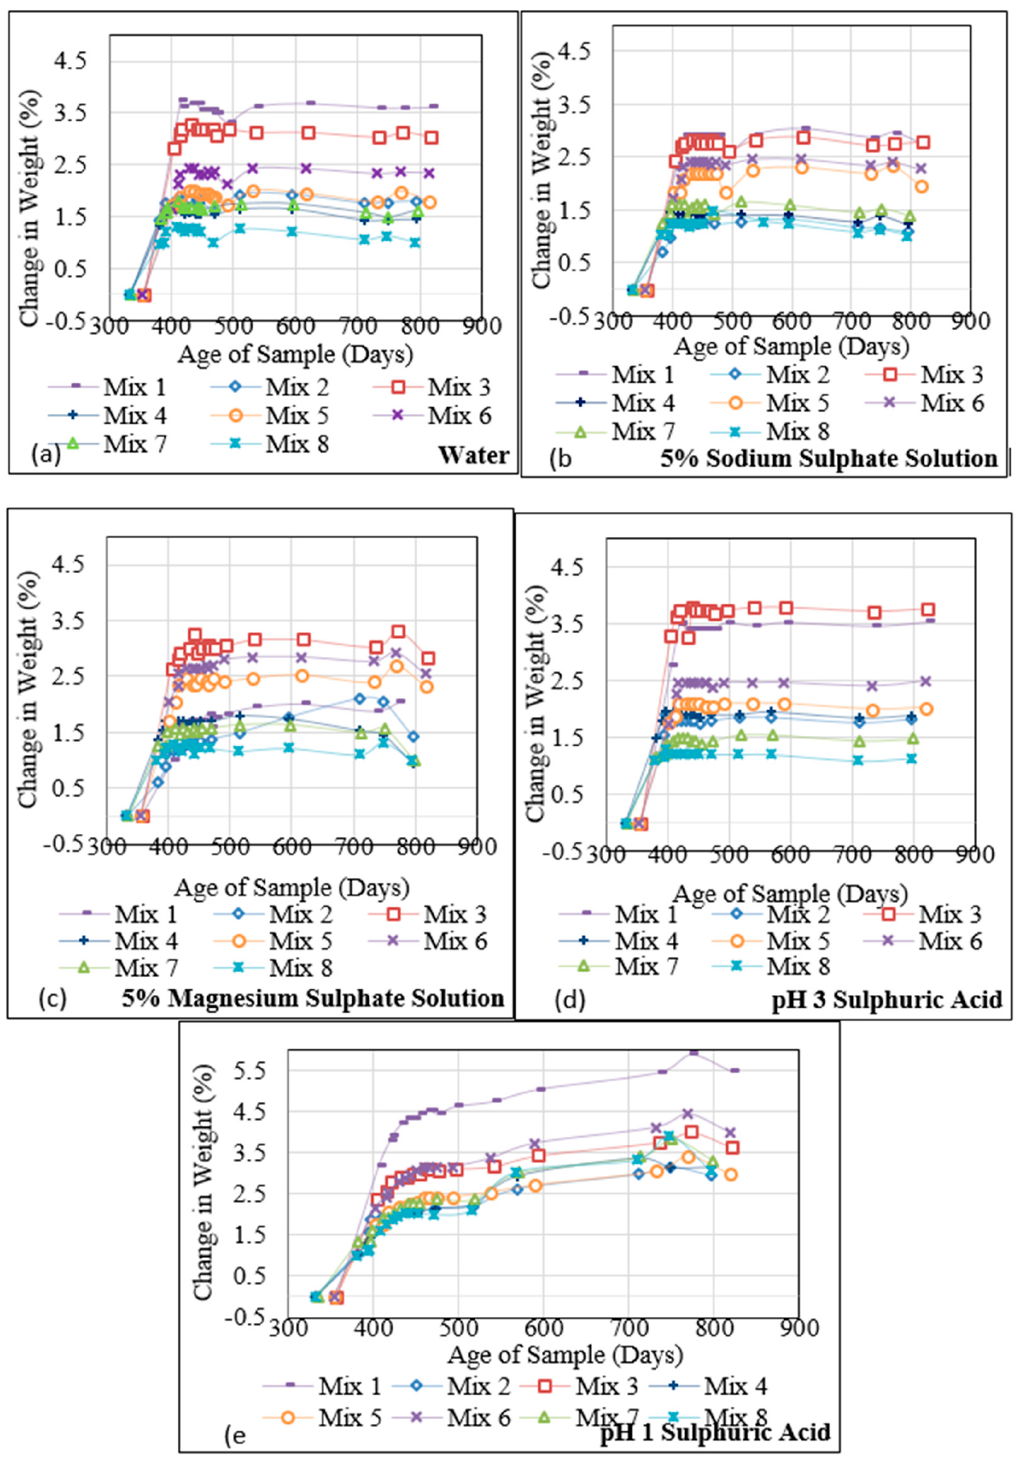
Figure 8. Change in weight of Group 2 AASC mixes (cured for a year before exposure) during im- mersion in different solutions [( a ) Water, ( b ) Na 2 SO 4 , ( c ) MgSO 4 , ( d ) H 2 SO 4 -pH 3, ( e ) H 2 SO 4 -pH 1].